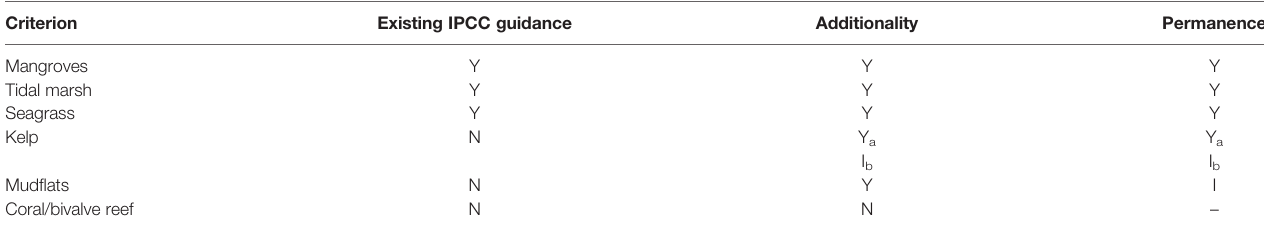
TABLE 1 | Assessment of con fi dence in coastal ecosystems in the context of principles central to verifying offsets through carbon markets.